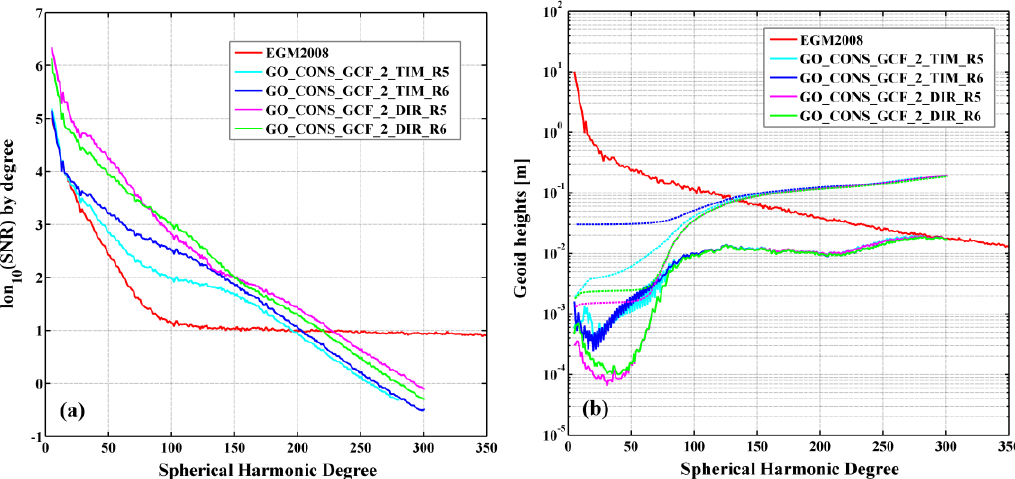
Figure 6. ( a ) Signal to noise ratios (SNRs) of GFMs and ( b ) difference degree errors (solid line) and difference cumulative degree errors (dashed line) between satellite-only GFMs and the EGM2008.